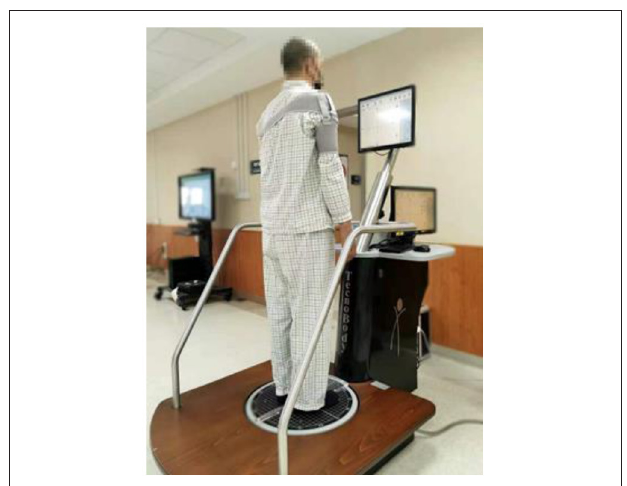
FIGURE 2 | Static Balance Assessed by the Pro-Kin